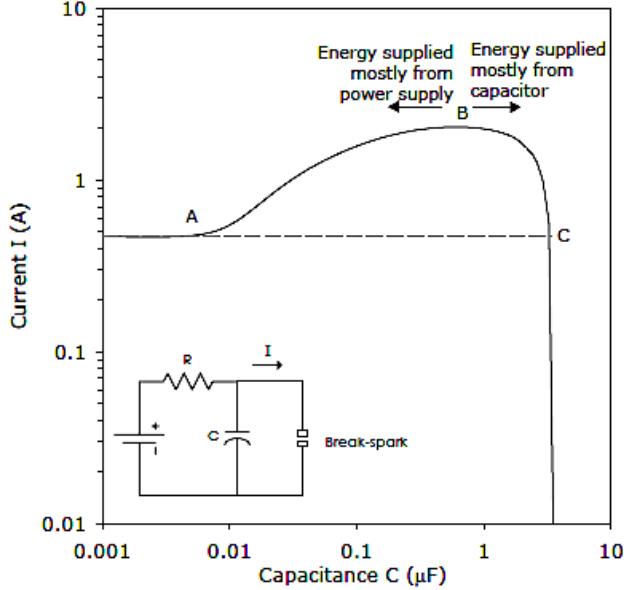
Figure 5. Current needed for the ignition of an 8.3% CH 4 /air atmosphere using the IEC 60079-11 apparatus fed from a 30 V power supply. At lower supply voltages, the curve would move up and to the right.